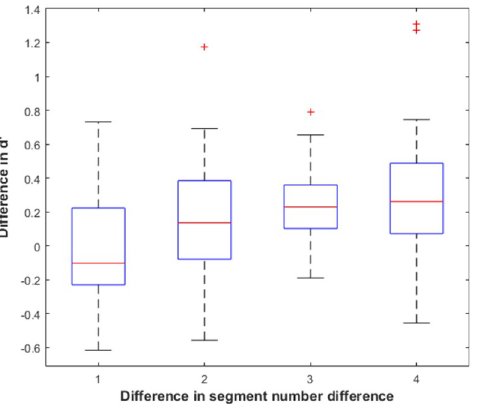
Fig 16. Sensitivity difference by segment number difference. The box shows the interquartile range of d’ differences for individual participants. The red line shows the sample median. The whiskers extend to the most extreme datapoint within 1.5 times the length of the interquartile range from the top or bottom edge of the box (covering 99.3% of the data if they are normally distributed). Outliers are data points beyond the whisker and are plotted as red